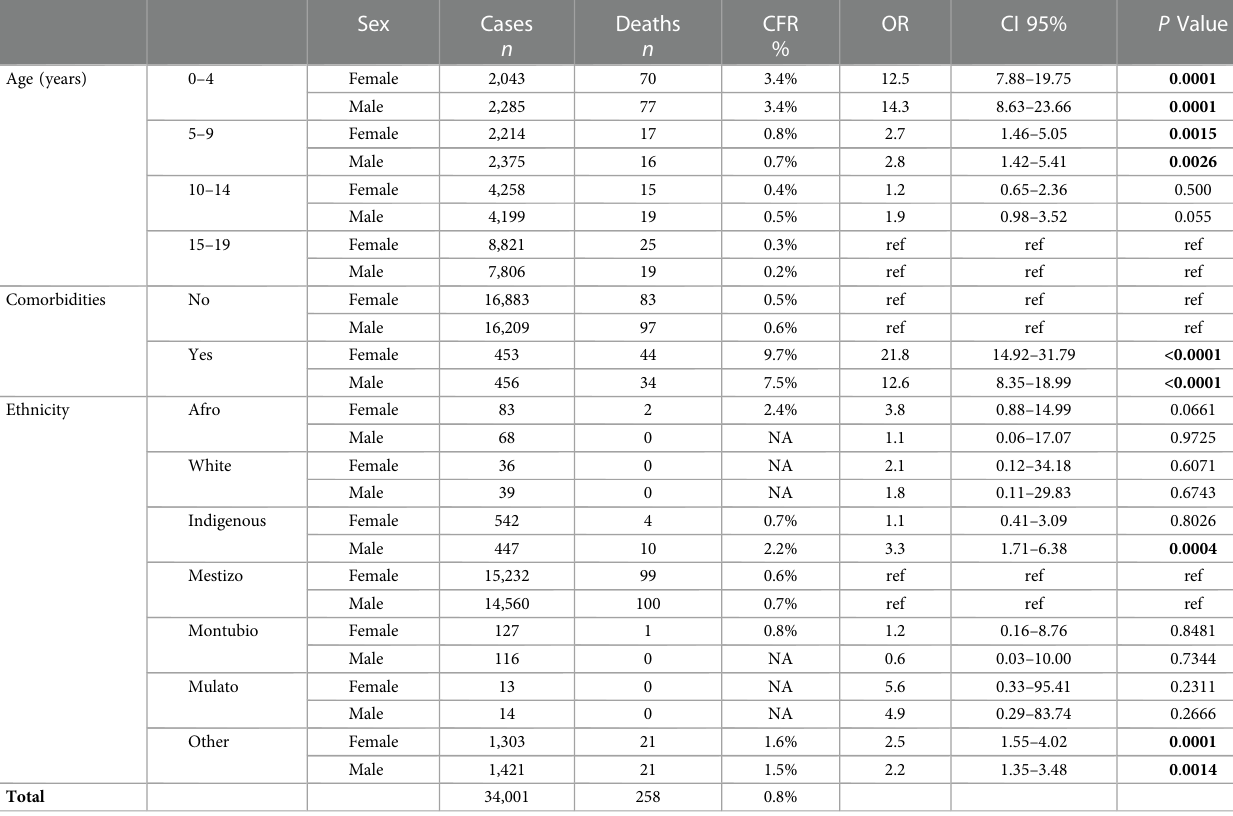
TABLE 3 Analysis of risk and probability of infection and death among children and adolescents with COVID-19 in Ecuador. Sex Cases